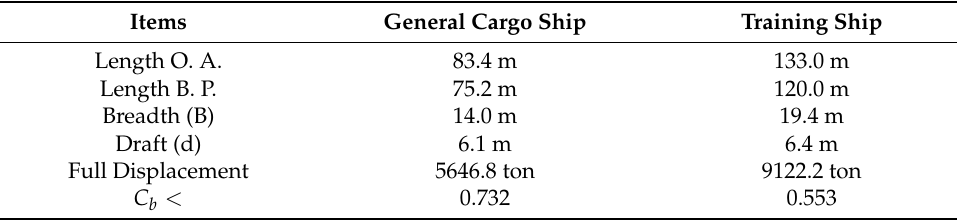
Figure 5. Model ships of general cargo ship ( Left ) and training ship ( Right ). Table 6. Particulars of model